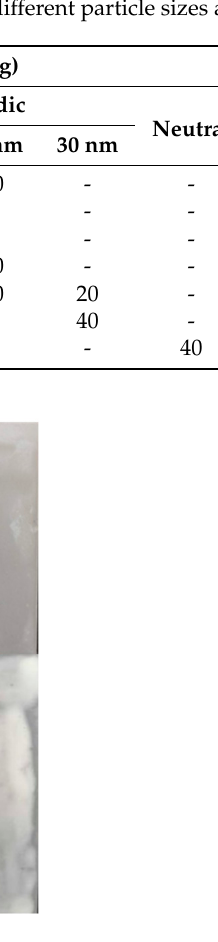
Figure 9. The morphology of coatings with silica sols of different particle sizes and acid base: ( a )